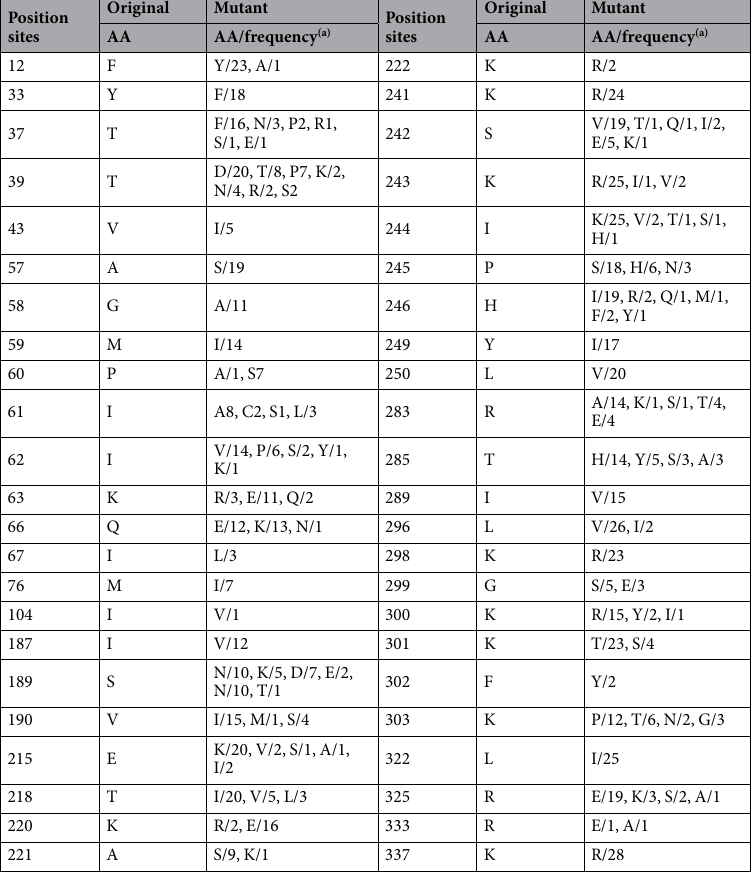
Table 1. The mutant residue types and frequencies of the non-conserved amino acids (AA). (a) The mutant residue types and frequencies were statistically analyzed using HotSpot Wizard 1.7 software based on the results of the multiple sequence alignment.